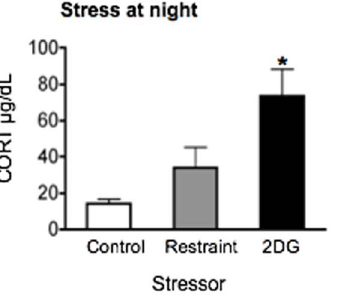
Figure 8. The effect of time of day of stress exposure on plasma corticosterone (CORT). Rats were exposed to 30 min restraint stress or treatment with 250 mg/kg 2DG administered during the nighttime at ZT14. Rats were killed at ZT15, 1 hour after stress onset. Means 6 SEM are shown, n =4 per group; * significant difference from corresponding control group, p , 0.05.